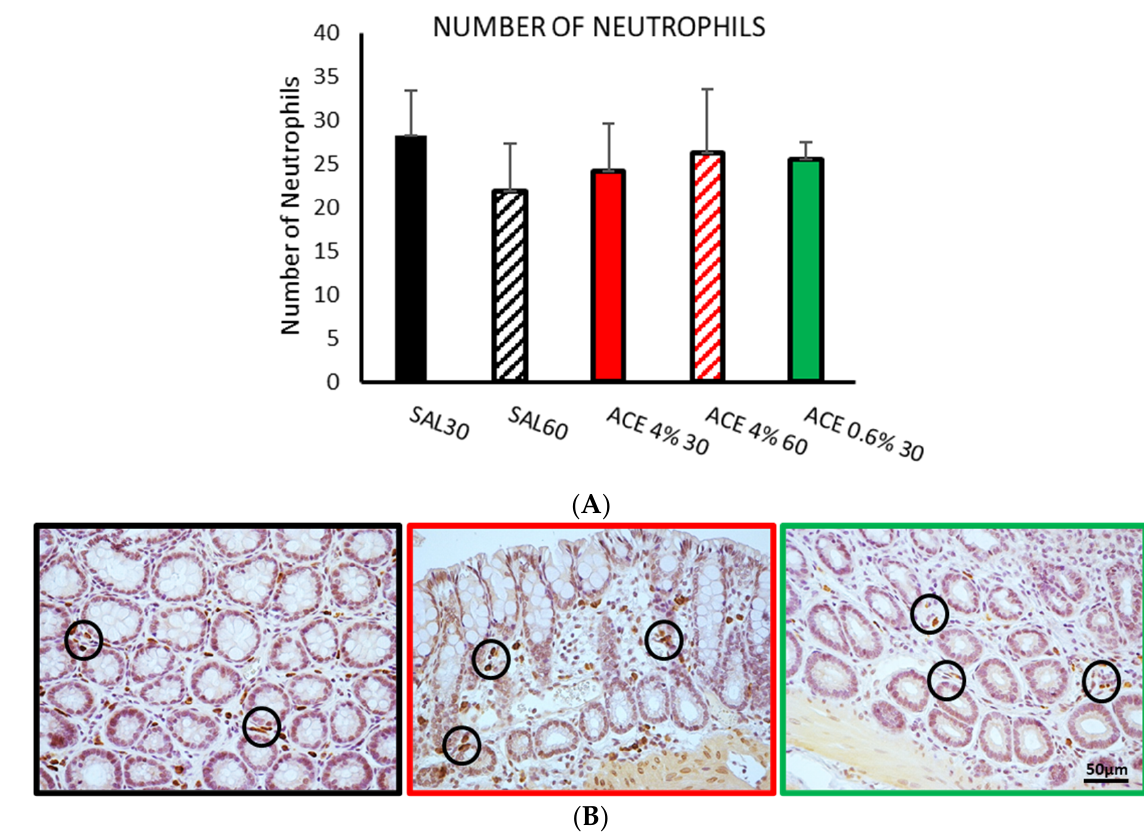
Figure 6. Effect of intracolonic administration of acetic acid on the number of neutrophils, phase I (model selection). The number of neutrophils ( A ) was assessed by immunohistochemistry and studied in ten random fields per section. Experimental groups: SAL30, black bar; SAL60, black striped bar; ACE 4% 30, red bar; ACE 4% 60, red striped bar; ACE 0.6% 30, green bar. Data represent mean ± SEM. One-way ANOVA followed by Bonferroni post hoc test ( n = 8–13). ( B ) Photomicrographs of myeloperoxidase immunopositive cells (neutrophils, see circles) in colonic mucosa after intracolonic administration of SAL30 (black frame), ACE 4% 30 (red frame), or ACE 0.6% 30 (green frame). Scale bar = 50 µ